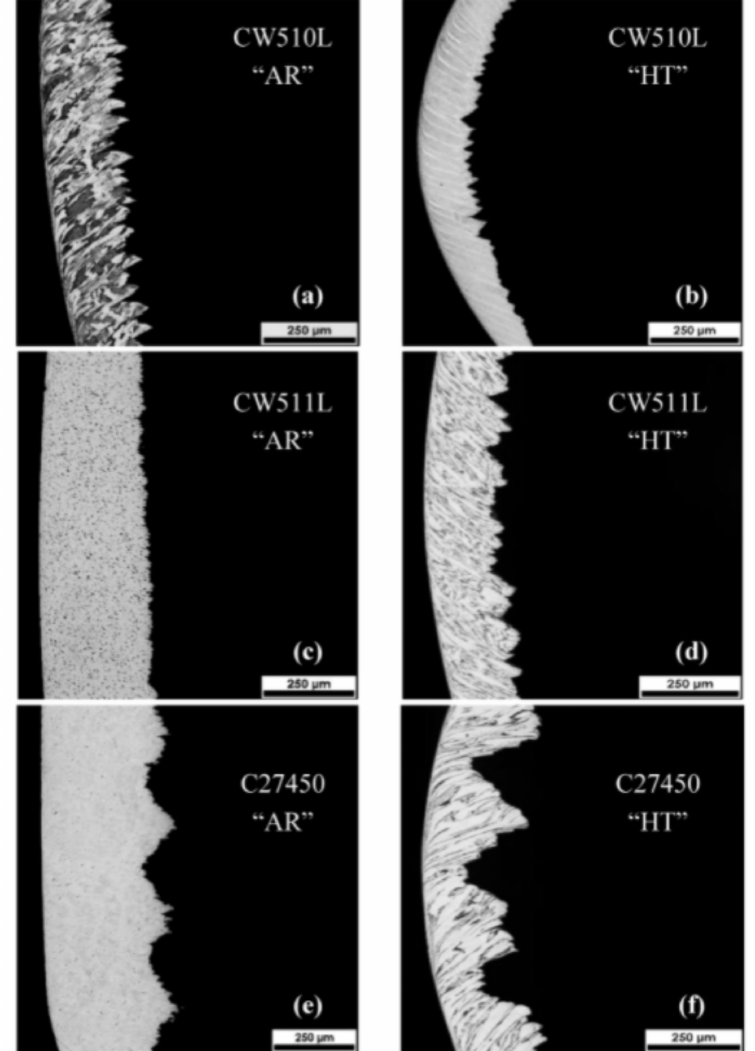
Figure 7. Optical micrographs showing the morphology of chips generated during the machining process of ( a ) CuZn42, ( c ) CuZn38As, ( e ) CuZn36 alloys before heat-treating (AR) and ( b ) CuZn42, ( d ) CuZn38As, ( f ) CuZn36 alloys after the heat-treatment process, HT